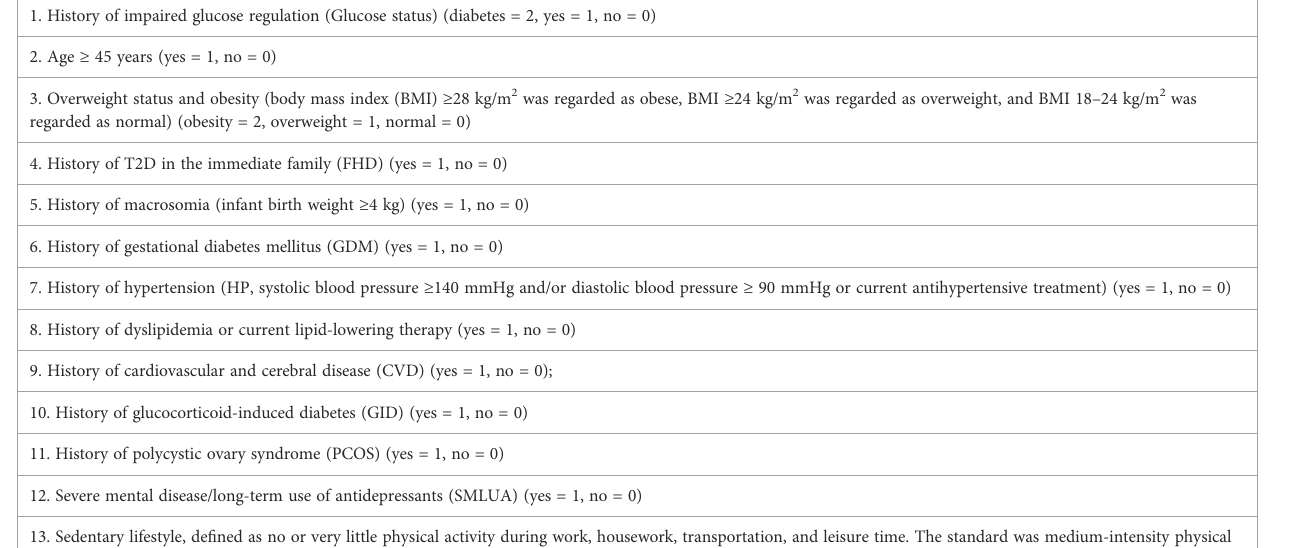
TABLE 1 Questionnaire on risk factors for type 2 diabetes mellitus